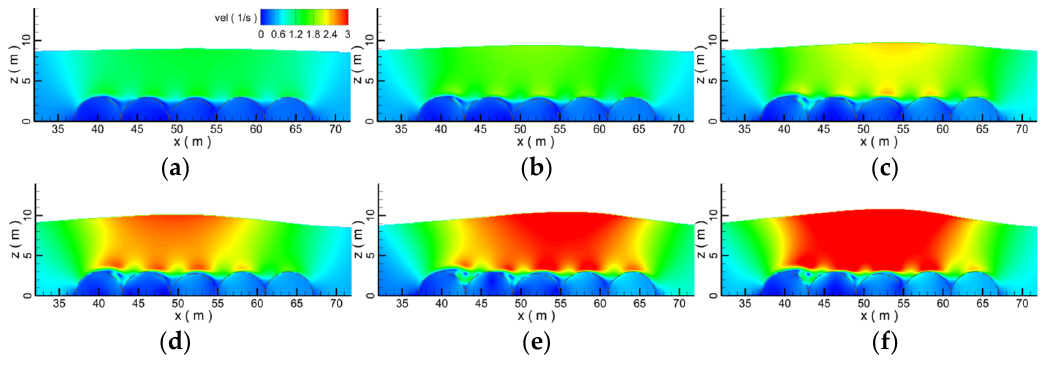
Figure 20. The velocity contour of the wave peak on the breakwaters under different wave heights;